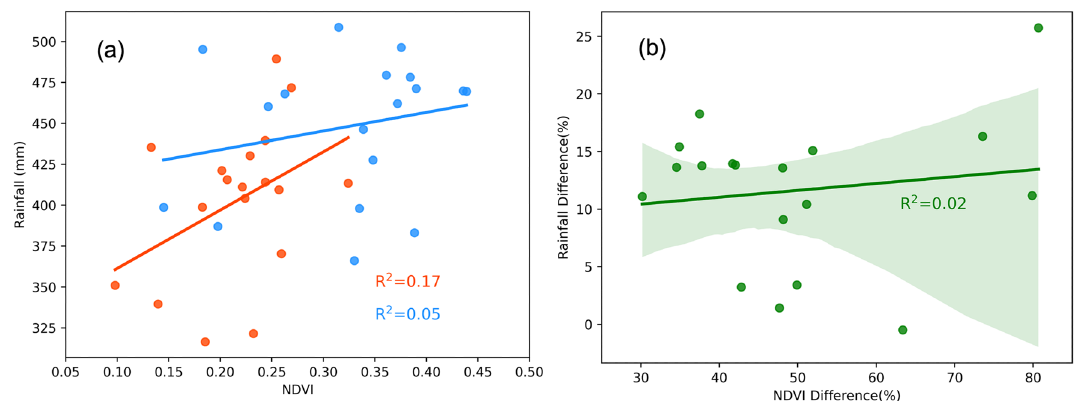
Figure 3. Scatter plots ( a ) showing relationship between the mean peak NDVI and total rainfall before (red) and after the intervention (blue) and ( b ) scatter plot between percent differences in NDVI and rainfall before and after intervention for each of the